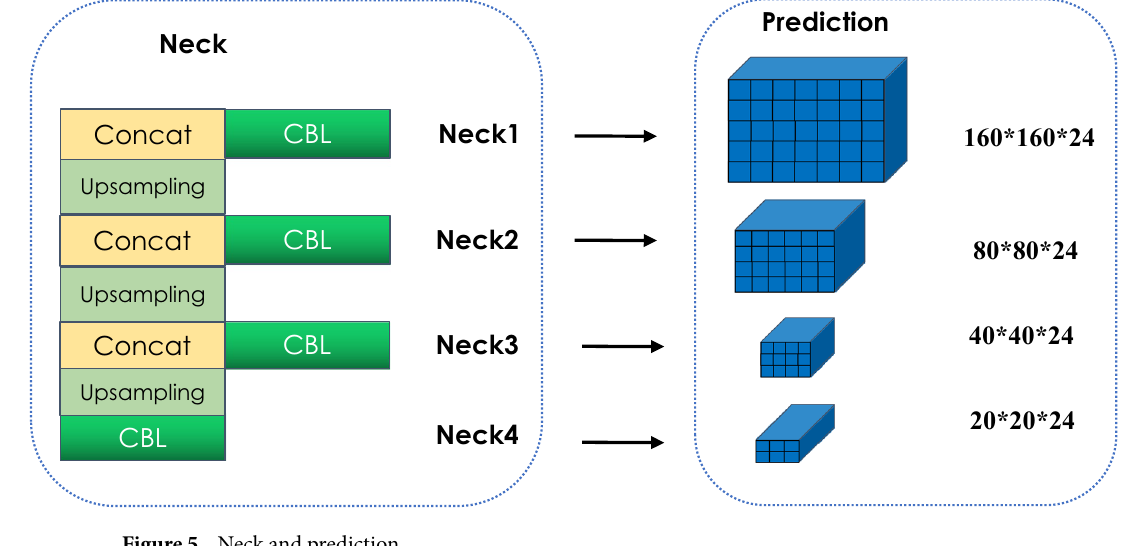
Figure 5. Neck and